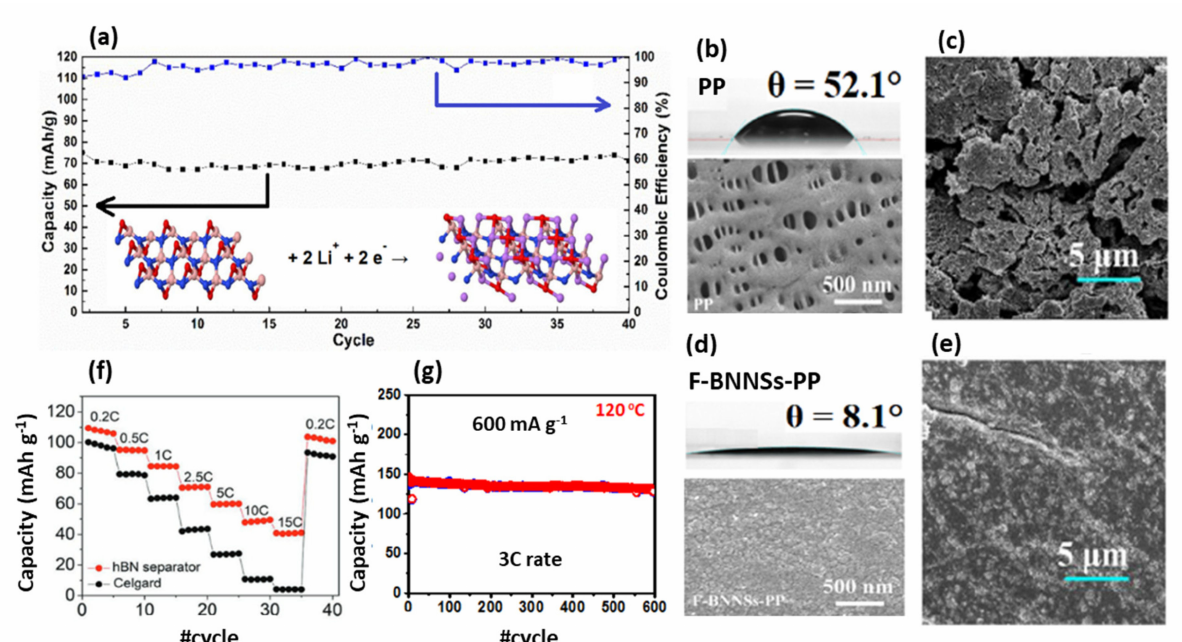
Figure 2. ( a ) Cyclic performance and Coulombic efficiency of FBN (inset: one possible redox energy storage mechanism for FBN) (Reprinted with permission from Royal Society of Chemistry, Copyright © 2016). Electrolyte-separator contact angle and top-view SEM images of the ( b , c ) PP and ( d , e ) F-BN-PP separator, respectively [64] (Reprinted with permission from American Chemical Society, Copyright © 2021). ( f ) rate capability of the LMO-graphene||Li cell at 0.5 C and from 0.2–15